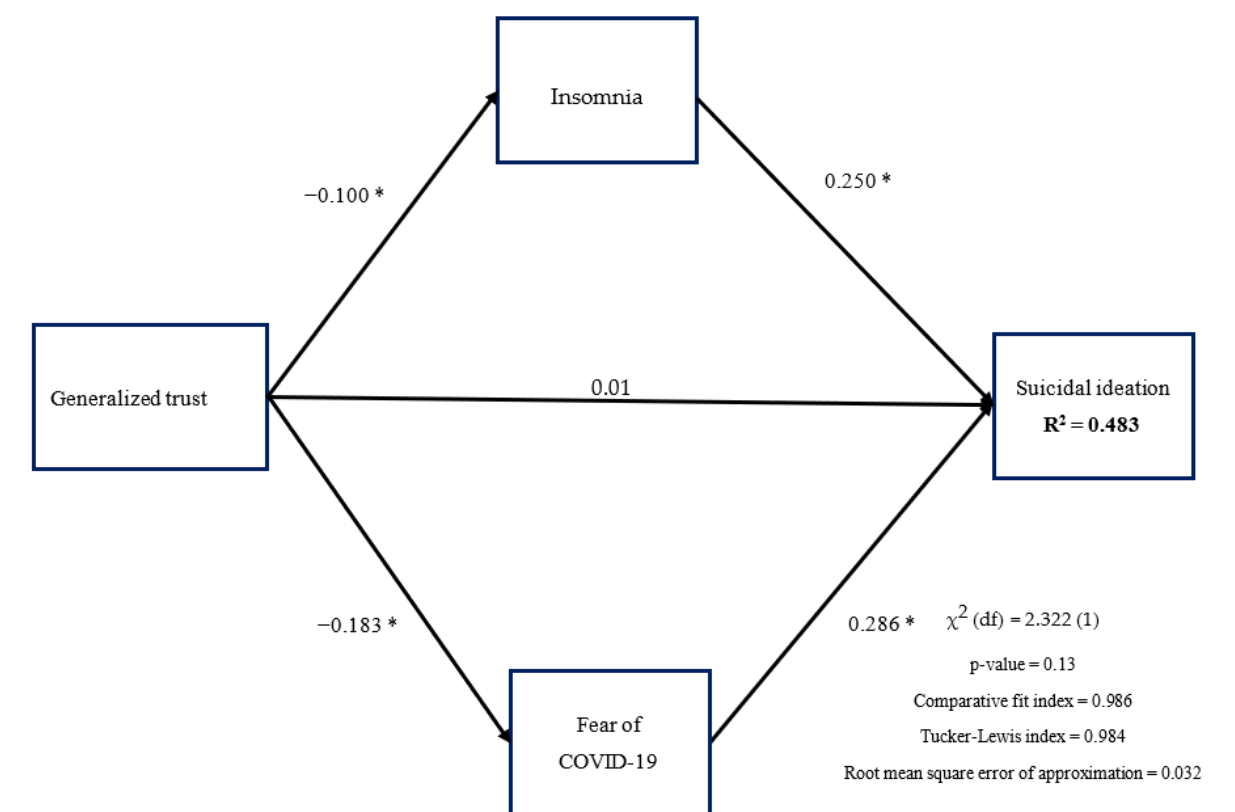
Figure 1. Hypothesized mediation model and findings. * p < 0.05. Table 2. Models that tested mediated effects of fear and insomnia. Stand.